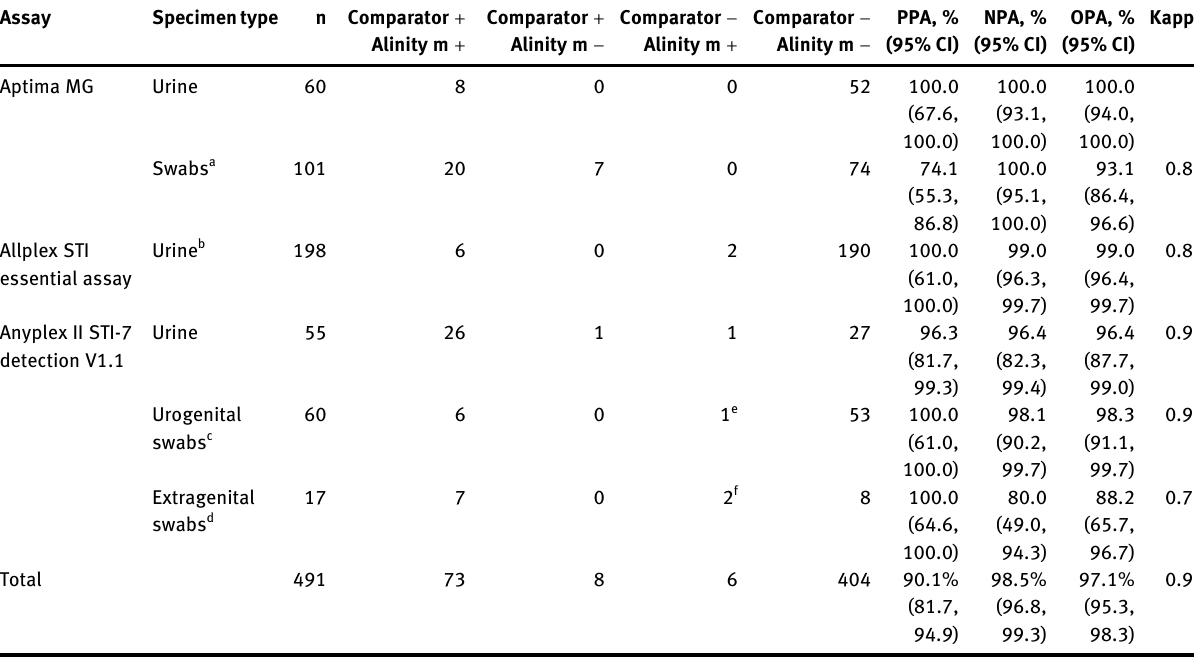
Table  : Performance of the Alinity m STI assay and comparator assays for M. genitalium. Assay Specimentype n Comparator +